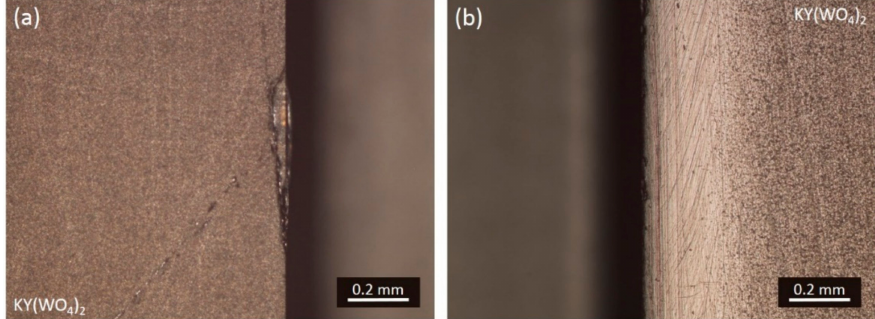
Figure 7. Microscope image of a fine lapped KY(WO 4 ) 2 edge ( a ) with defect and ( b ) after